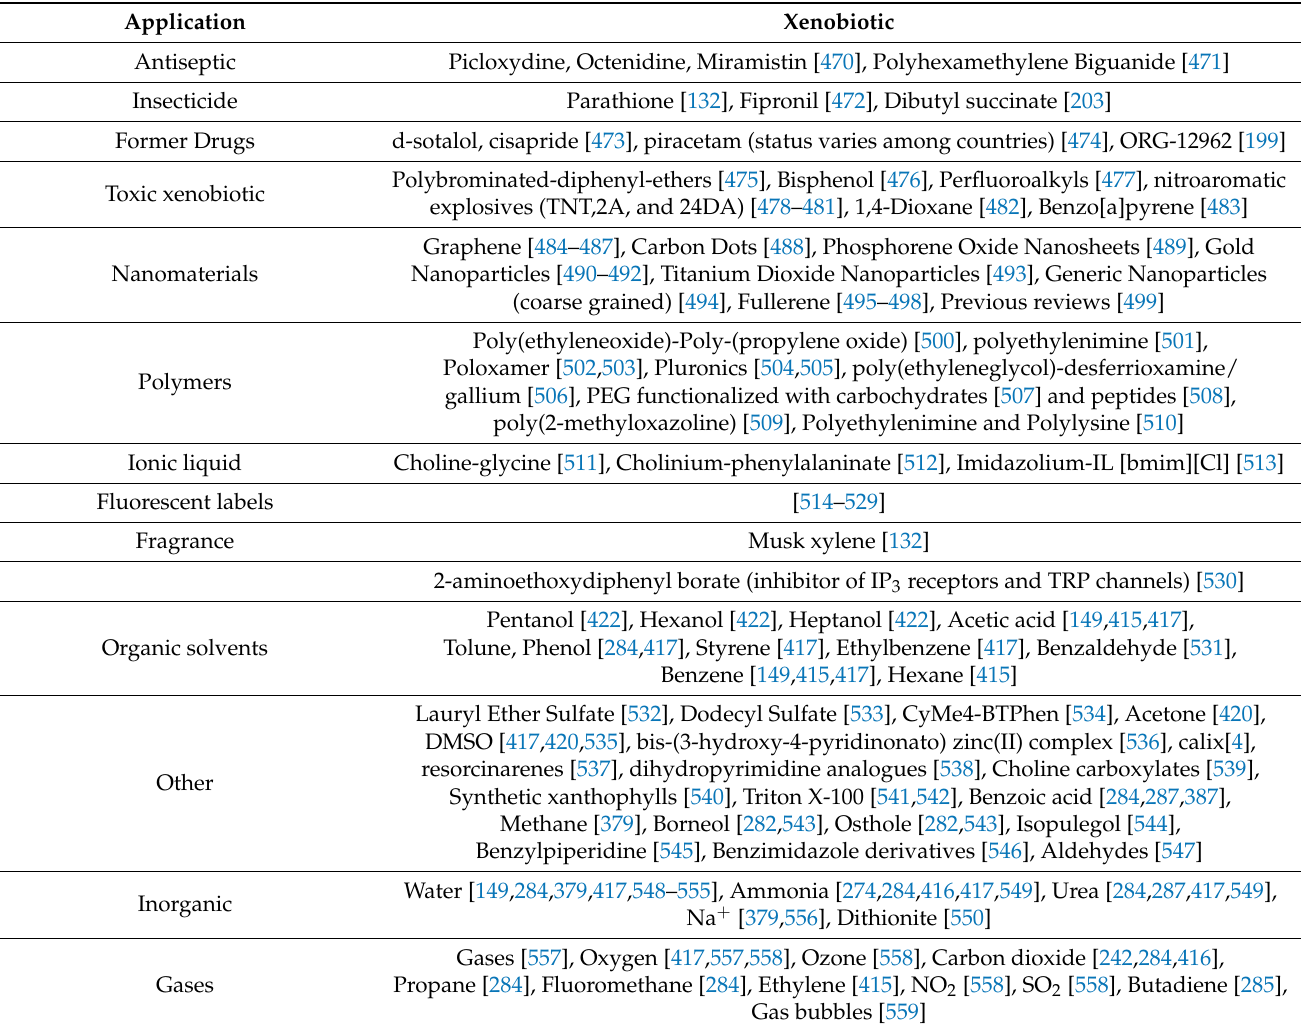
Table 3. List of recent studies of xenobiotic–membrane